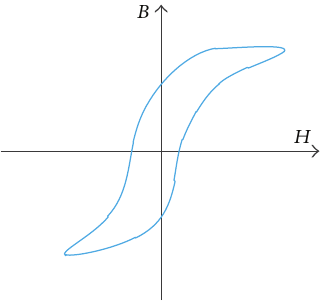
Figure 3: Typical B-H hysteresis curve.